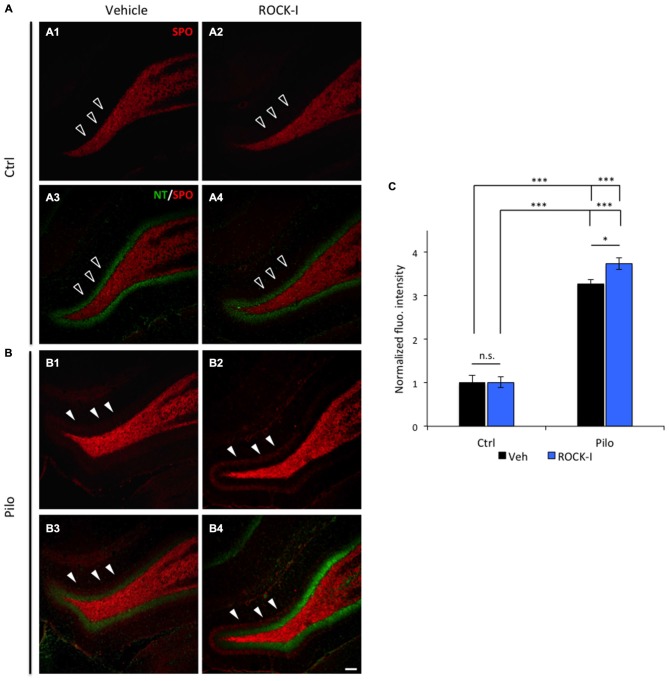
Y-27632 treatment increases early ectopic recurrent mossy fiber sprouting (rMFS) in the dentate gyrus of pilocarpine rats. Immunohistochemical staining with synaptoporin antibody (SPO, red) labeled the mossy fibers and neurotracer staining (NT, green) labeled cell body of the DG granule cells. (A) Synaptoporin staining revealed no ectopic rMFS band in the molecular layer of the DG in both ventral and dorsal DG in control vehicle- (A1,3; empty arrowheads) and Y-27632-treated rats (A2,4; empty arrowheads). (B) Synaptoporin staining revealed an ectopic rMFS band in the molecular layer of the DG in both ventral and dorsal DG in pilocarpine vehicle- (B1,3; arrowheads) and Y-27632-treated rats (B2,4; arrowheads). (C) The histogram represents the quantification of the fluorescence intensity of synaptoporin in control vehicle- and Y-27632-treated, and pilocarpine vehicle- and Y-27632-treated rats. The data are normalized to control vehicle-treated rats (n = 3 for control vehicle-treated rats; n = 4 for control Y-27632-treated rats; n = 3 for pilocarpine vehicle-treated; n = 4 for pilocarpine Y-27632-treated). Data are means ± SEM; *p < 0.05; ***p < 0.001, p values were determined by Tukey multiple-comparison test following two-way ANOVA analysis. Scale bar = 20 μm.